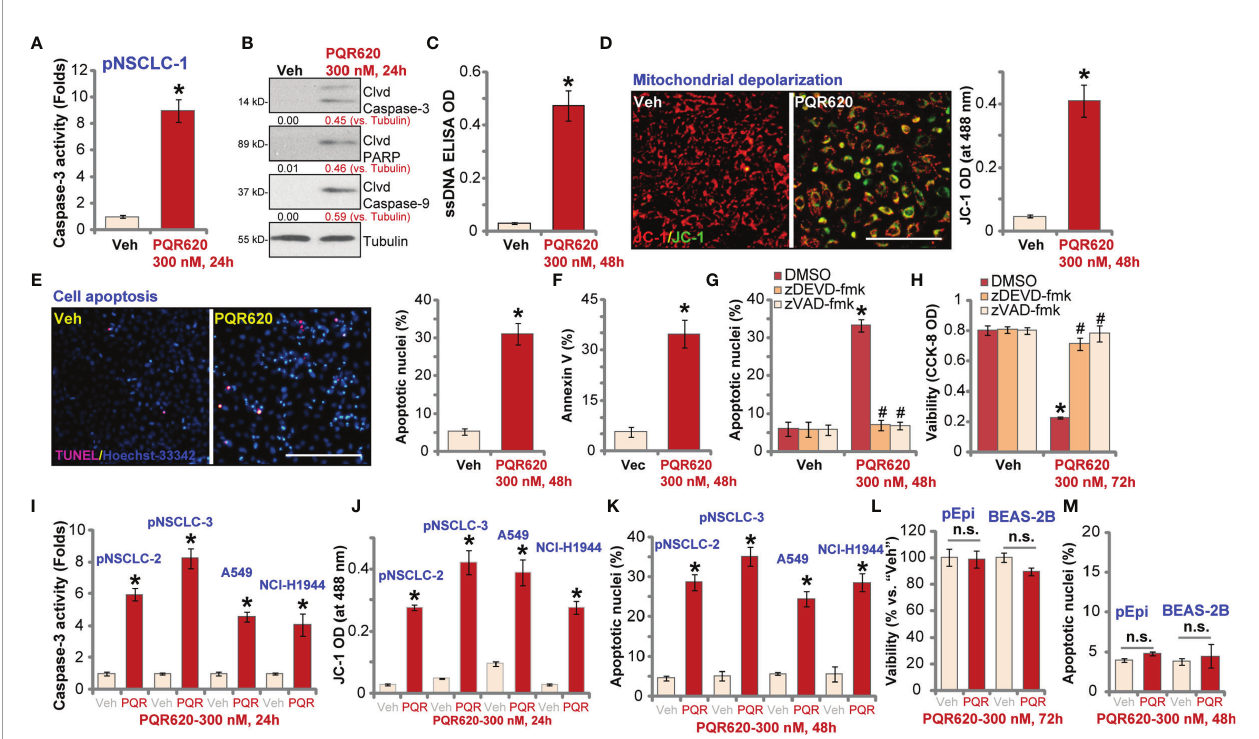
FIGURE 2 | PQR620 provokes apoptosis activation in NSCLC cells. Primary NSCLC cells were derived from three different patients (pNSCLC-1/-2/-3). Established NSCLC cell lines (A549 and NCI-H1944), human lung epithelial cells ( “ pEpi ” ), or BEAS-2B cells were treated with PQR620 (300 nM) or vehicle control ( “ Veh ” ). Cells were further cultured for indicated time periods, caspase activation (A , B , I) , single strand DNA contents (ELISA assays, C ), mitochondrial depolarization (JC-1 green monomers accumulation, D , J ) were tested. Cell apoptosis was tested by Hoechst-33342 apoptotic nuclei staining assays (E , K , M) and Annexin V-FACS assays (F) , with cell viability tested by CCK-8 assays (L) . pNSCLC-1 cells were pretreated for 30 min with z-DEVD-fmk (35 m M) or z-VAD-fmk (35 m M), followed by PQR620 (300 nM) treatment. Cells were cultured for applied time periods, with cell apoptosis and viability tested by apoptotic nuclei staining (G) and CCK-8 (H) assays, respectively. Data were presented as mean ± standard deviation (SD, n=5). * p < 0.05 vs. “ Veh ” cells. # p < 0.05 vs. DMSO group (G , H) . “ n.s ” , non-statistical difference (L , M) . Experiments were repeated fi ve times with similar results. Scale bar= 100 m m (D , E)